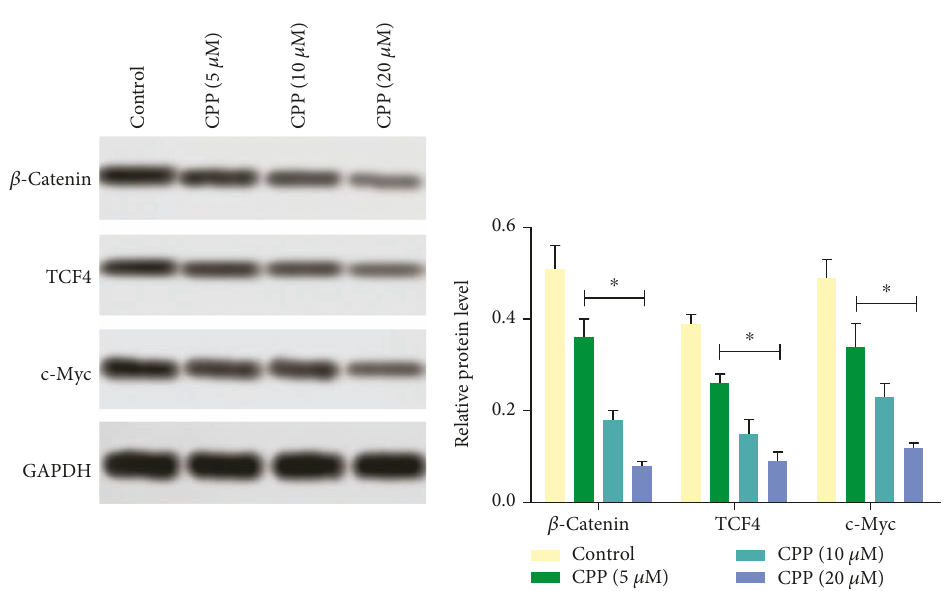
Figure 6: Expression of signaling pathway protein in HepG2 cells. ∗ P < 0 05 versus Control